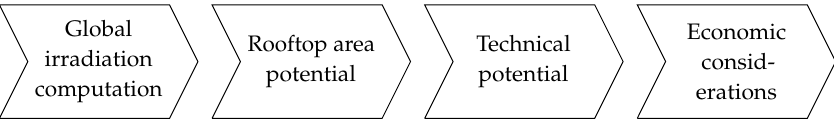
Figure 1. Main steps of a PV potential